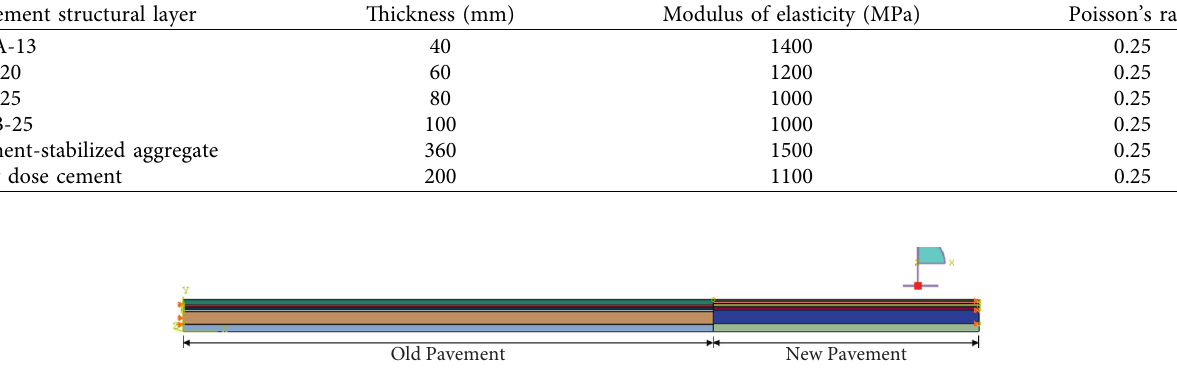
Figure 14: Finite element model of pavement structure.